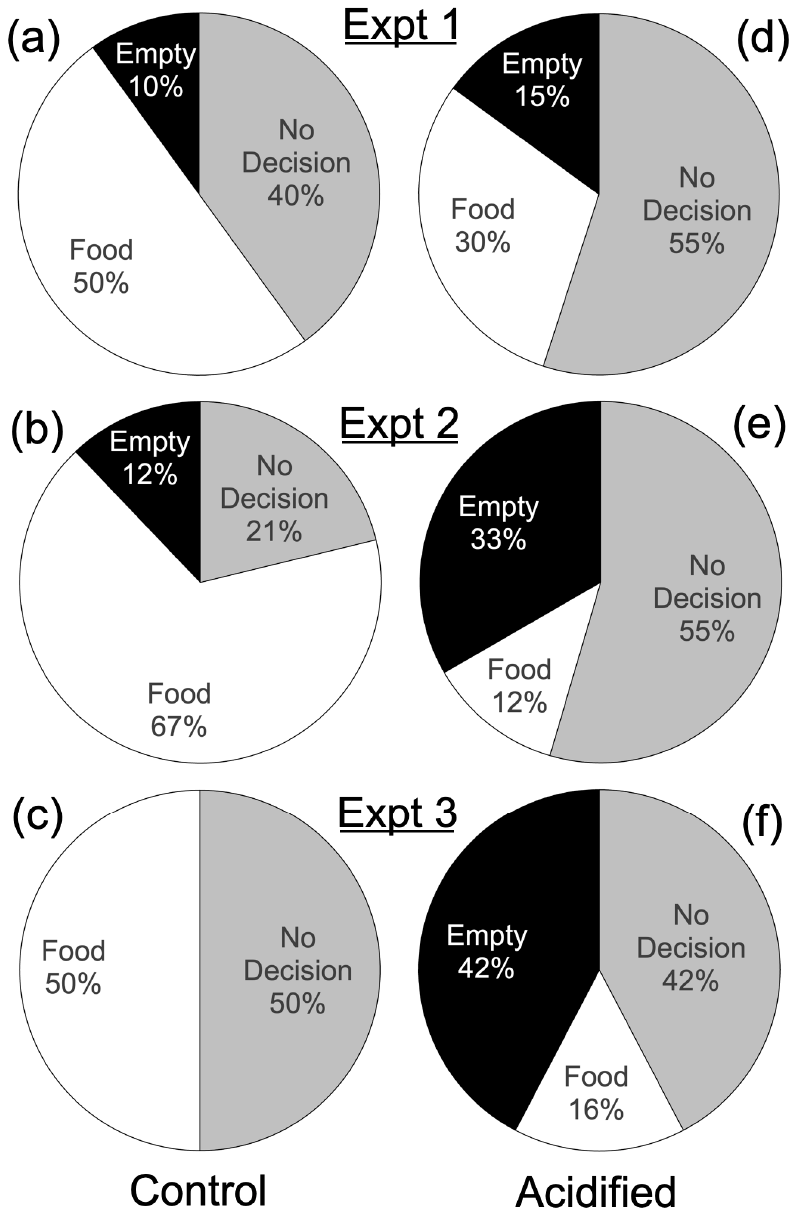
Figure 2. Pie charts showing the decisions of snails under control and acidified conditions in all three sets of experiments. In all 3 sets of control experiments ( a , b , c ), snails chose the food at least 5 times as often as the empty chamber. This was greatly reduced in acidified treatments ( d , e , f ), where far fewer snails found the food and more chose the empty side of the Y-maze. Sample sizes were 20 ( a ), 33 ( b ), and 16 ( c ) for the control treatments and 20 ( d ), 33 ( e ), and 26 ( f ) for the acidified treat- ment.